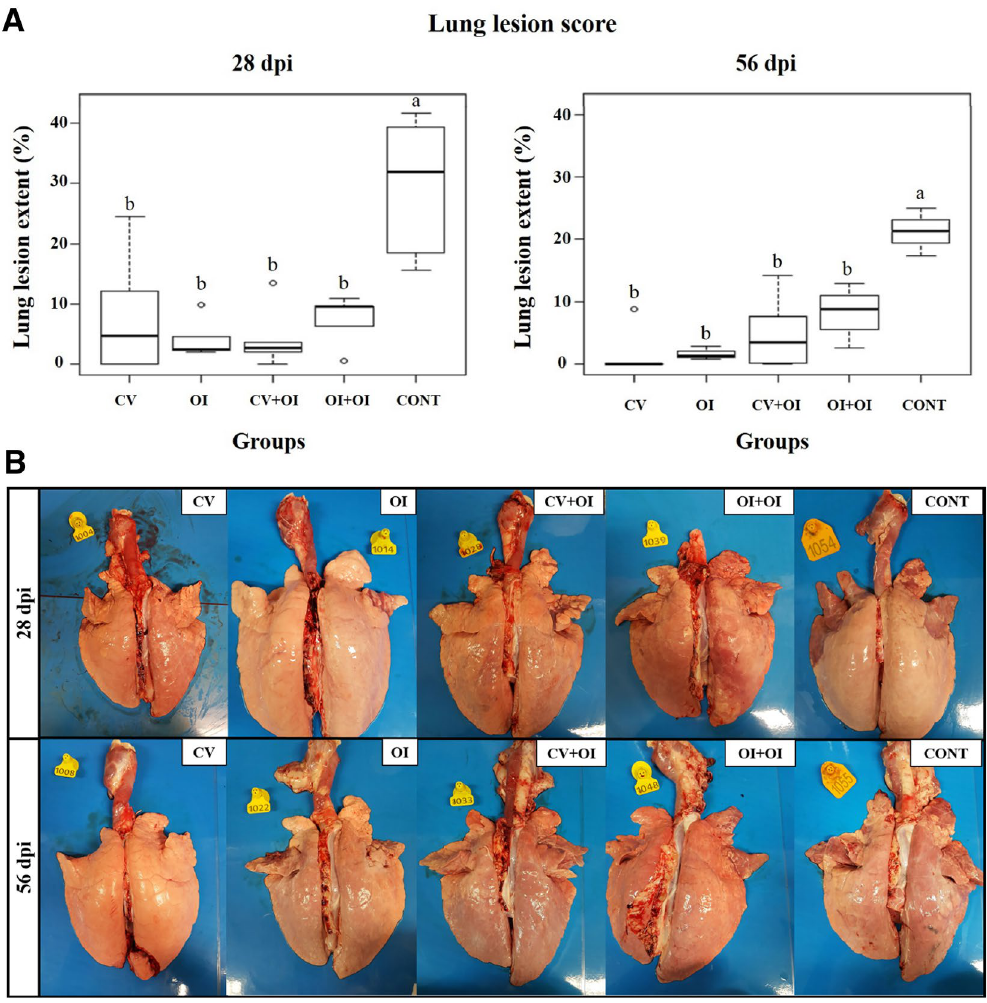
Figure 1. ( A ) Comparison of Mycoplasma -like macroscopic lung lesions extent observed at slaughter of piglets, 28- and 56-days post-infection with M. hyopneumoniae . Means followed by the same letter do not differ statistically from each other (Tukey test). ( B ) Representative photos of Mycoplasma -like macroscopic lung lesions extent observed at slaughter of piglets, 28- and 56-days post-infection with M. hyopneumoniae